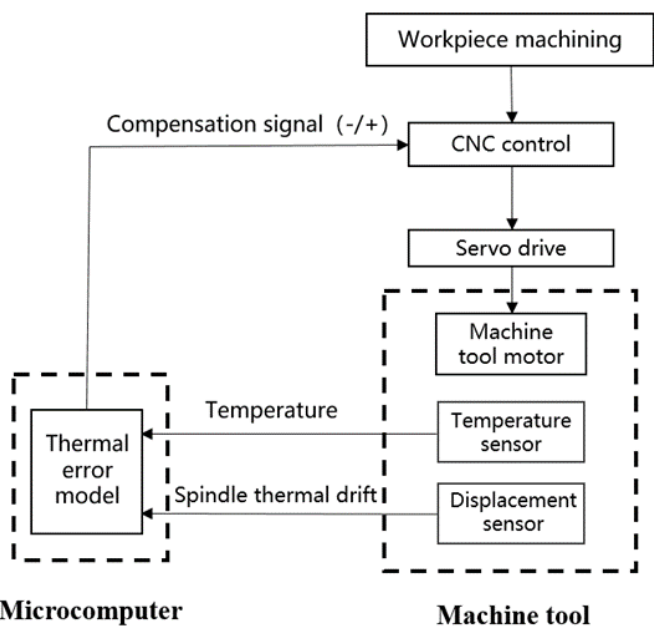
Figure 1. Thermal error compensation principle diagram.